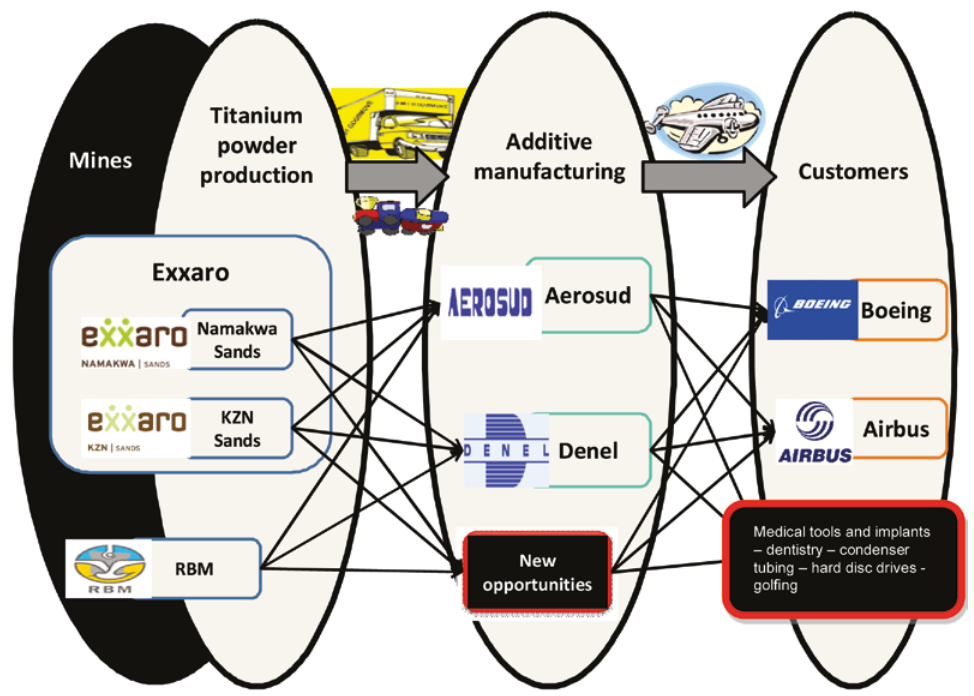
Figure 8: Proposed South African titanium supply